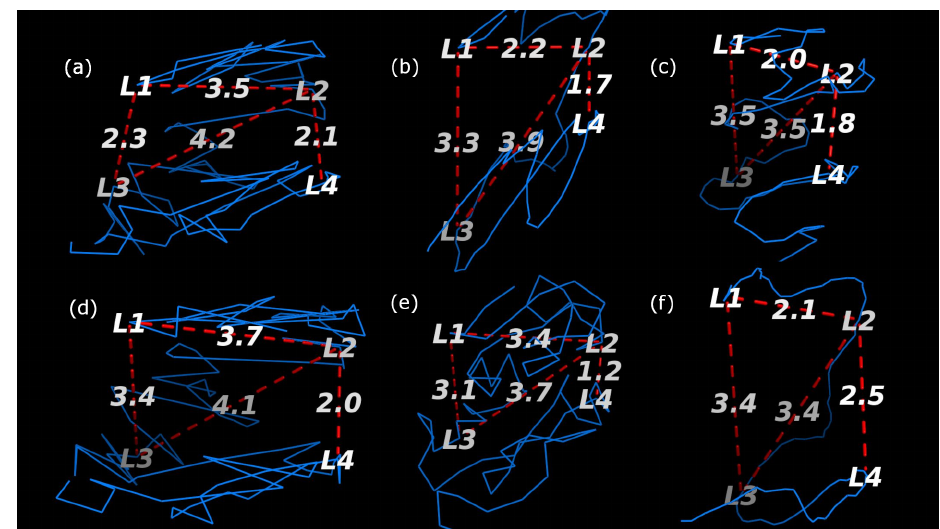
Figure 10. Fish Data Validation on Chromosome 14 from GM06990 litigated with HindIII at Resolu- tion 1 mb. The blue line denotes the generated structure. The four probes (L1,L2,L3, and L4) from [5] are labeled on the chromosome, and the important distances between them have been labeled by red dashed lines. The methods used to generate each structure are as follows: ( a ) ChromeBat, ( b ) LorDG,